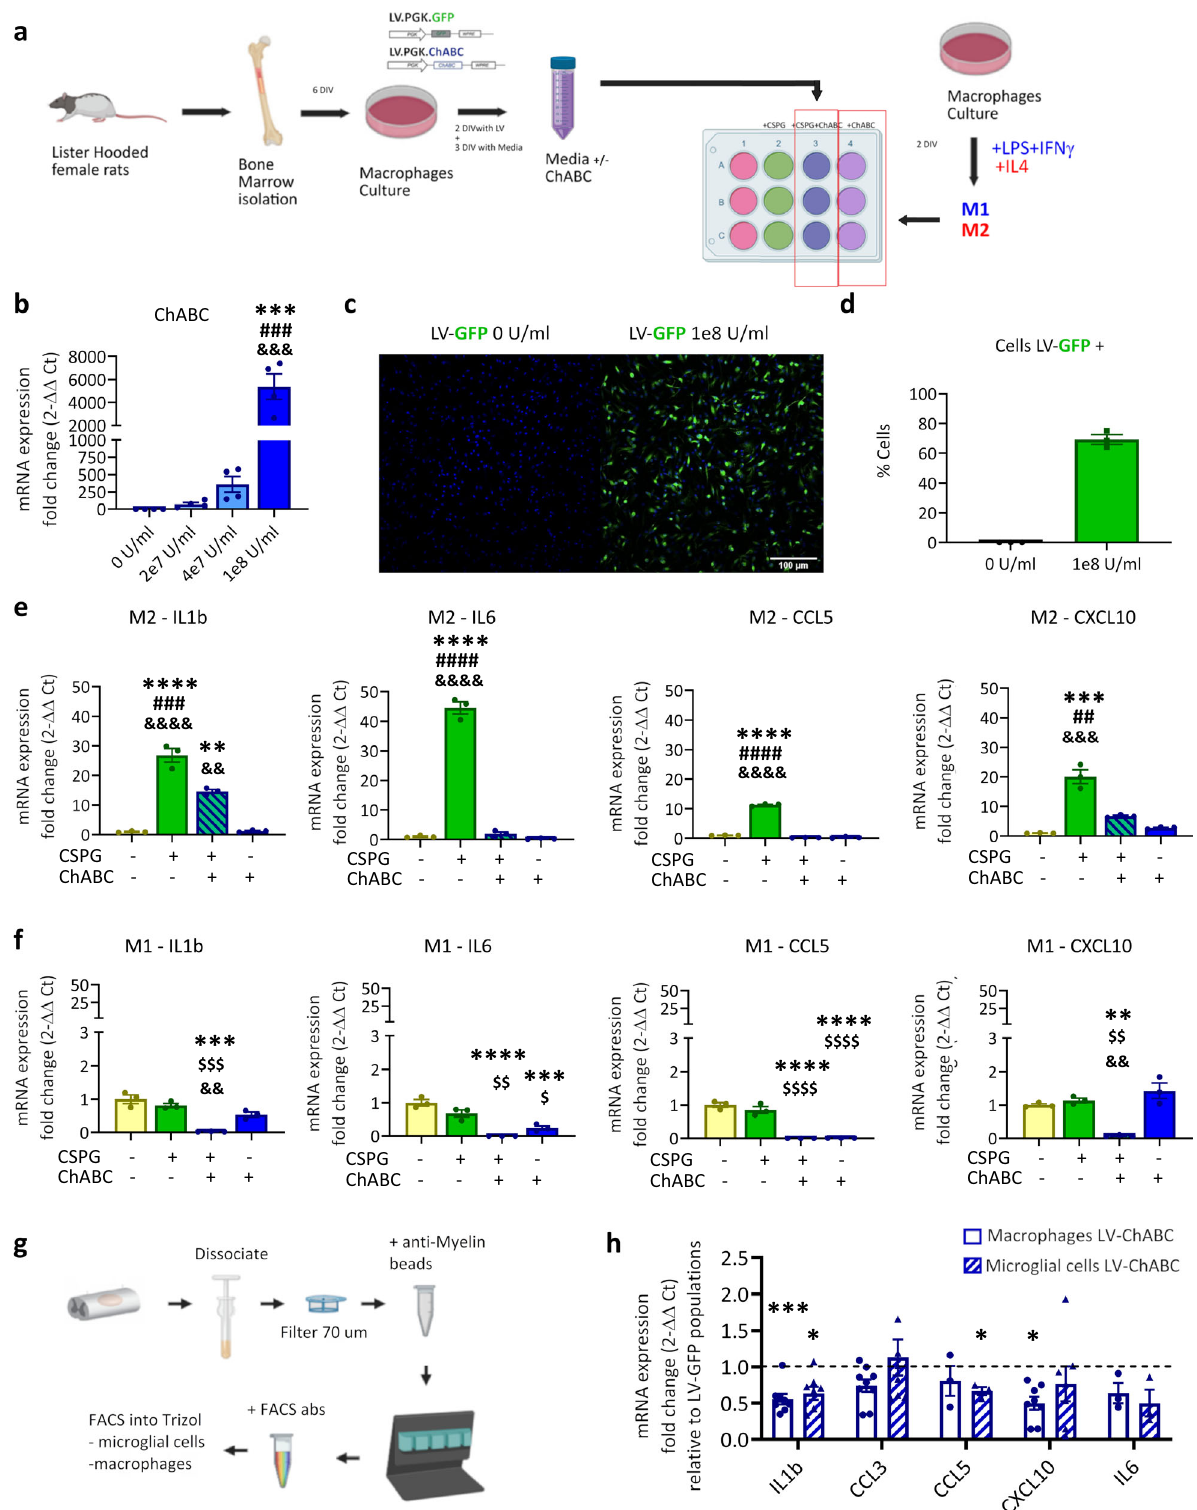
phosphorylation of p38 in M2-like polarised macrophages at both 4 and 16 h but did not affect other MAPK or NF-kB signalling pathways (Extended Data Fig. 13b, d). The effect of CSPGs on p38 pathway activation was corroborated by fl uorescence intensity in mouse M1/M2-like polarised macrophages (Extended Data Fig. 13e, f) where 4 h CSPG incubation induced higher p-p38/p38 ratio fl uorescence